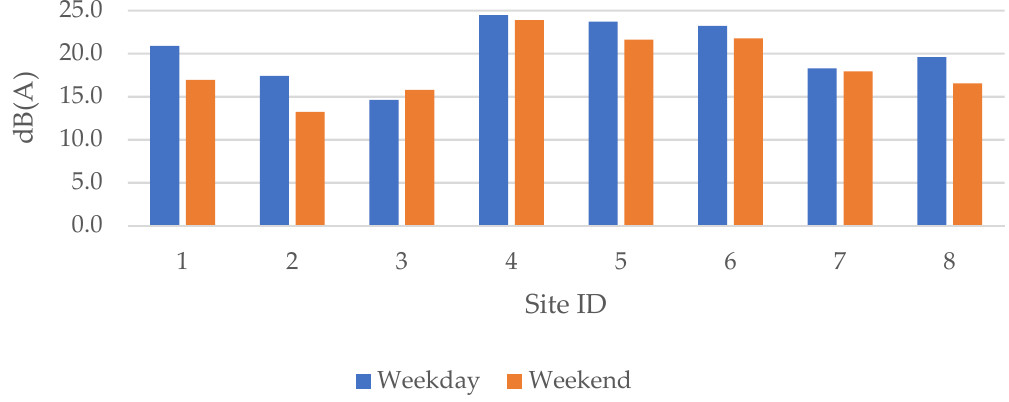
Figure 5. Daytime residual noise levels, Δ L = (L AFeq . Daytime –53) dB(A).